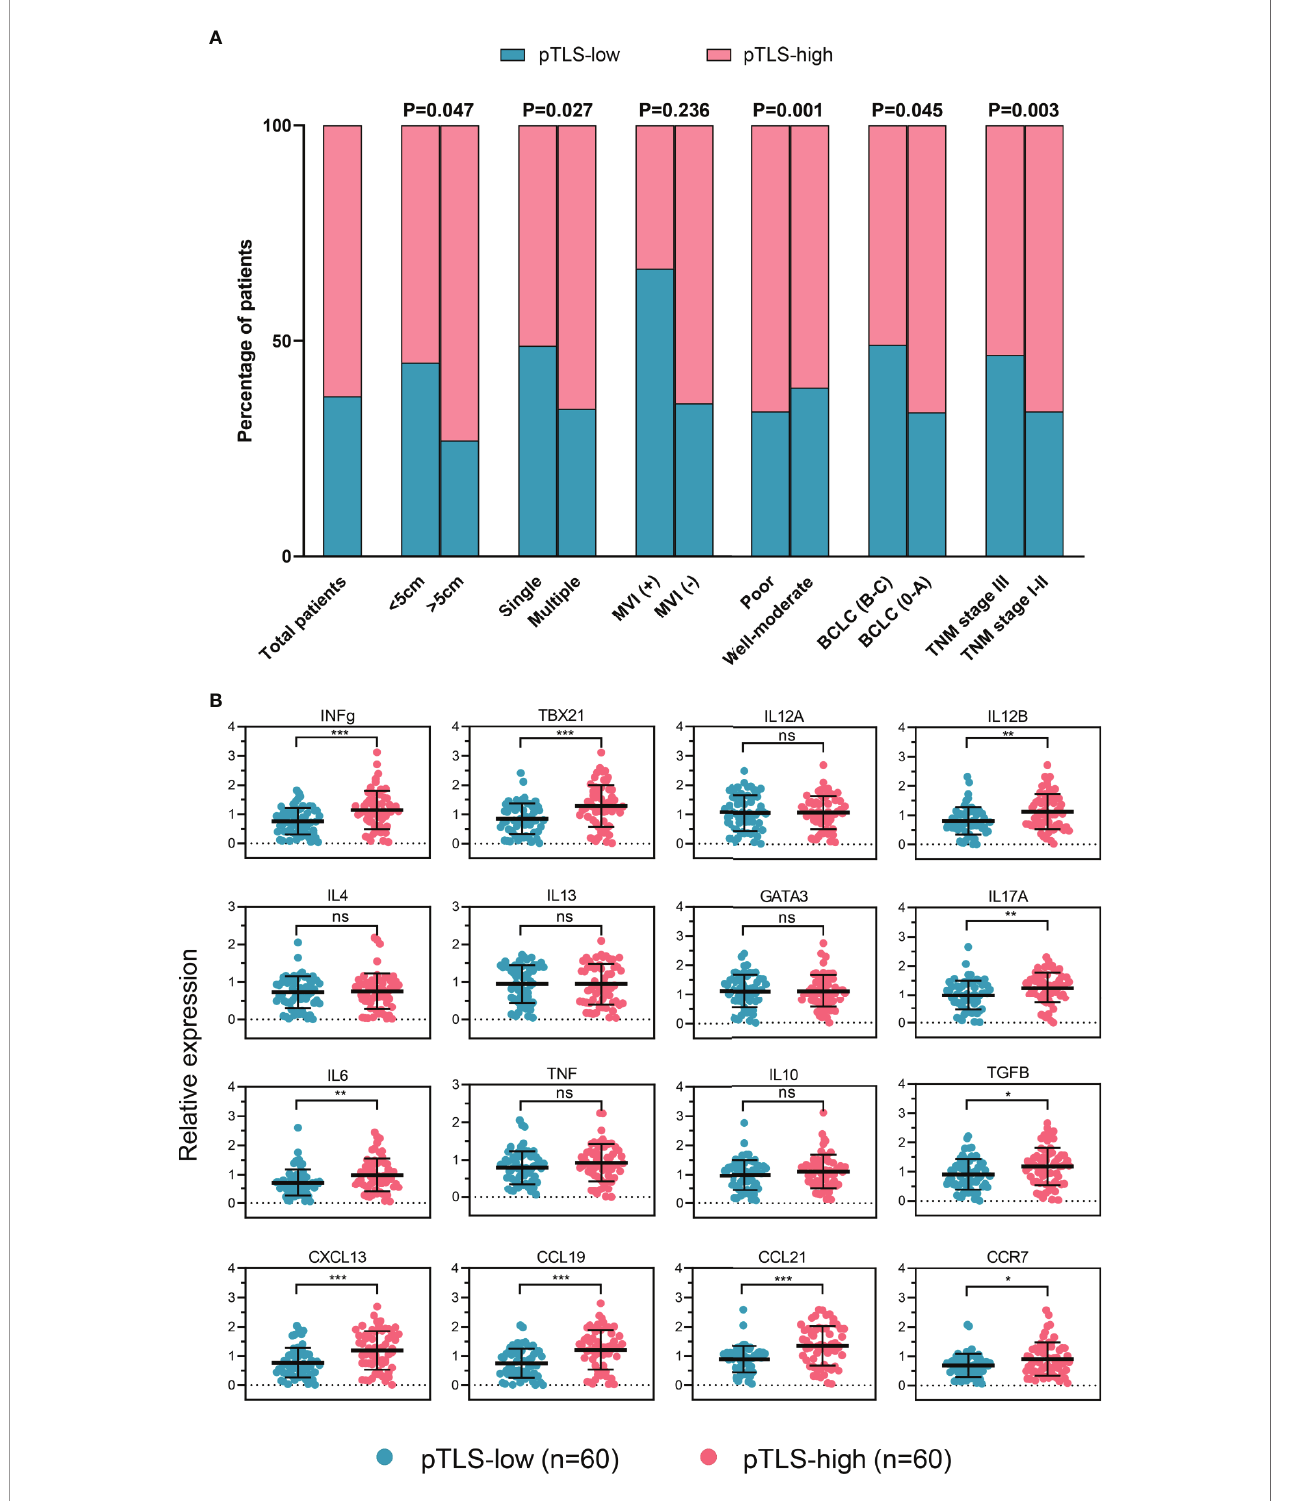
FIGURE 4 | The density of pTLS correlates with clinicopathological features and tumor immune microenvironment. (A) pTLS-low or pTLS-high tumors in total HCC patients and in groups of patients strati fi ed by clinicopathological features. (B) Expression of genes related to tumor immune microenvironment in HCC tissues of low pTLS (n=60) and high pTLS density (n=60), analyzed by real-time PCR. Groups were statistically compared using Mann – Whitney U-test. *P < 0.05; **P < 0.01; ***P < 0.001; ns, not signi fi cant. HCC, hepatocellular carcinoma; pTLS, peritumoral tertiary lymphoid structure; IHC,